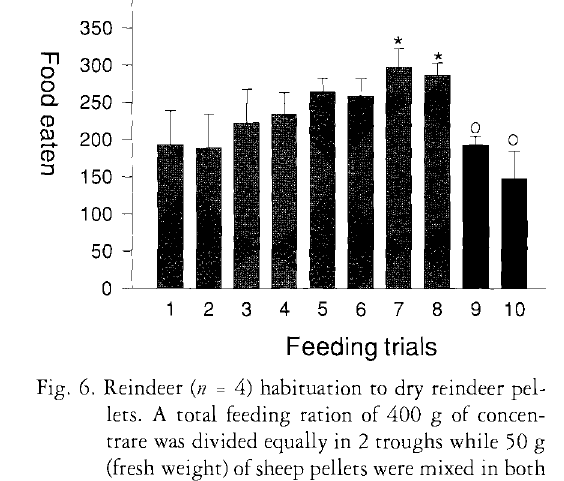
Fig. 6. Reindeer (» = 4) habituation to dry reindeer pel lets. A total feeding ration of 400 g of concen- trare was divided equally in 2 troughs while 50 g (fresh weight) of sheep pellets were mixed in both troughs. After 8 consecutive trials with dry dung (gray bars), the reindeer pellets in the last 2 trials were soaked in water for 12 hours (black bats). All trials were tested for significant differences (*) using trail 1 as a control group, while the last 2 trials were also tested for significant differences (0) using trail 8 as a control group (Friedman's repeared measures analysis of variance on ranks followed by Dunnet's multiple comparison tests, P <